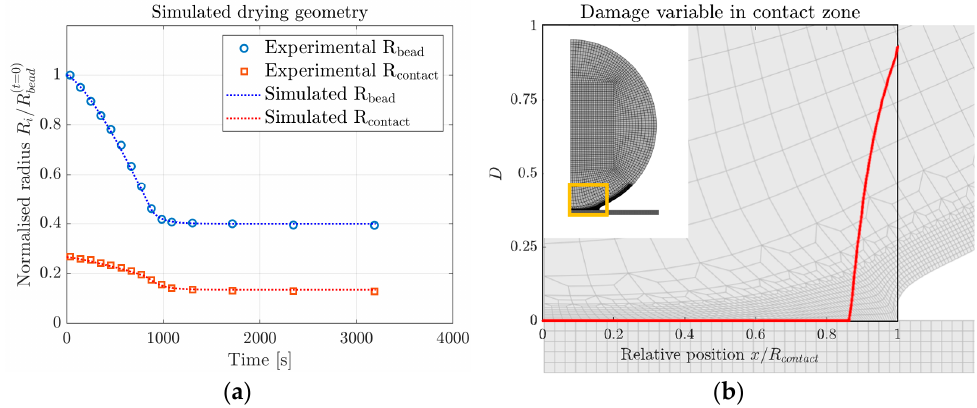
Figure 7. Results from simulations: ( a ) geometry evolution obtained by fitting of drying and diffusion coefficients, compared to experimental data replotted from Li et.al. [15] and ( b ) damage variable D (red) plotted for the last time step in the deformed model. Table 2. Resulting material parameters in the model given for the initial and final values of the moisture content, m 0 c and m ∞ c , respectively.